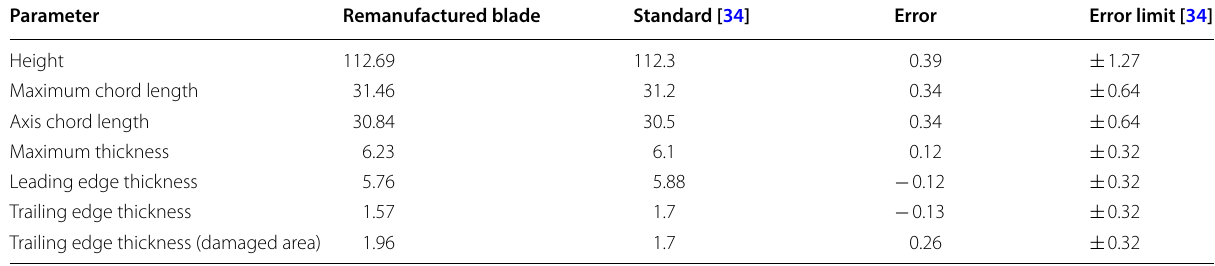
Table 5 Comparison of key parameters of the blade between the remanufactured and manual’s data